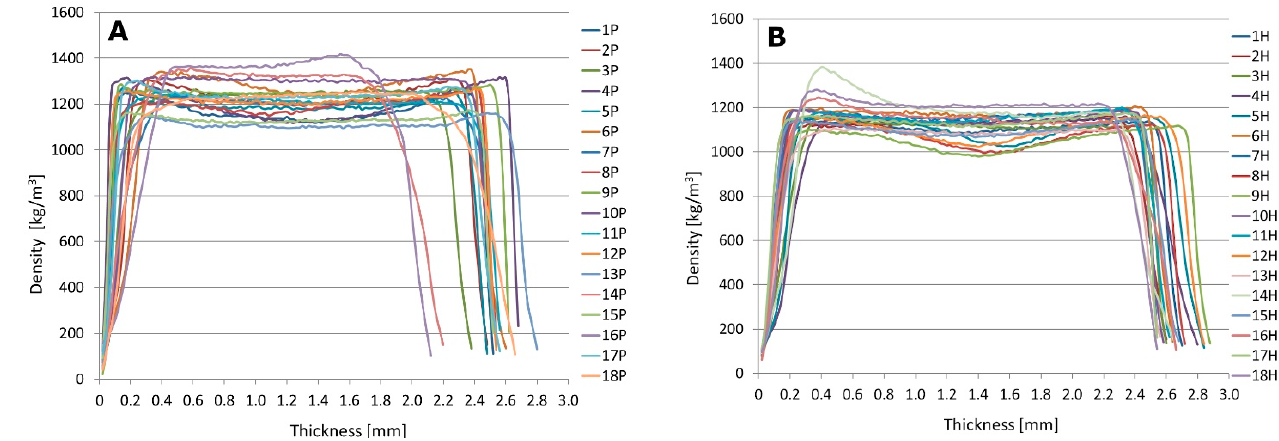
Figure 2. Density profiles of PLA-based composites ( A ) and HDPE-based composites ( B ).